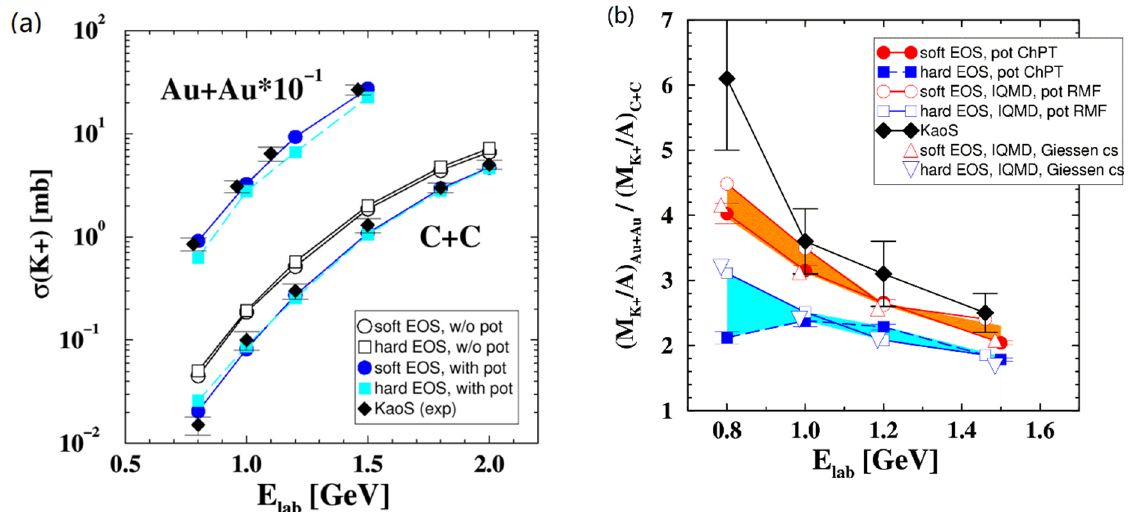
Figure 14. ( a ) Production cross-sections of K + mesons measured in Au+Au and C+C collisions as functions of the projectile energy per nucleon (black diamonds). The data are compared to QMD calculations with (full symbols) and without (open symbols) kaon in-medium modifications, assuming a soft EOS (K nm = 200 MeV; blue dots) or a hard EOS (K nm = 380 MeV; cyan squares). ( b ) Ratio of the K + multiplicity per mass number in Au+Au over C+C collisions as a function of beam energy. The data are compared to different QMD calculations assuming a soft EOS (K nm = 200 MeV; red symbols) or a hard EOS (K nm = 380 MeV; blue symbols). Taken from [57].